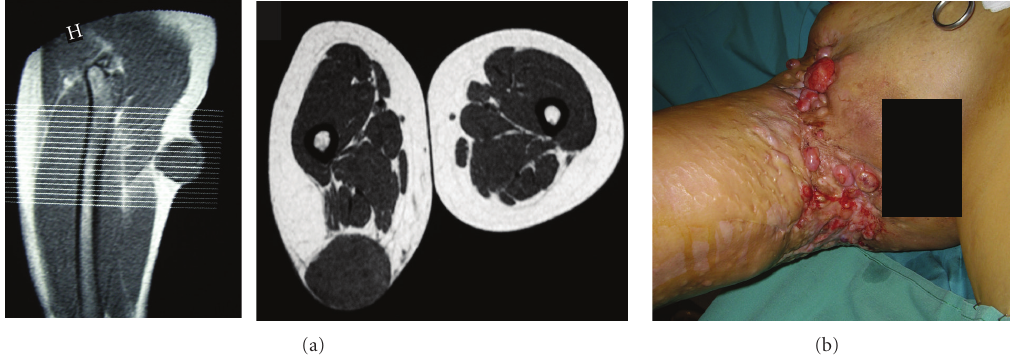
Figure 2: (a) An example of the few patients in group C for whom we have data about the primary lump. Thigh T1-MR, showing a subcutaneous lump (Malignant Fibrous Histiocytoma) in the groin. The mass was excised, in another hospital, without regard for basic oncologic rules. (b) Clinical image showing how we first encountered the patient, who had su ff ered multiple local recurrences.